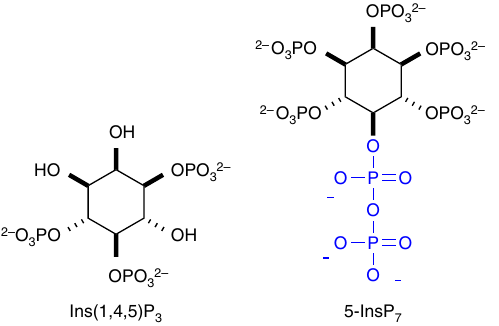
Figure 1 | Phosphorylated second messengers derived from myo -inositol. Chemical structures of myo -Inositol 1,4,5-trisphosphate and 5-diphospho- myo -inositol pentakisphosphate (5-InsP 7